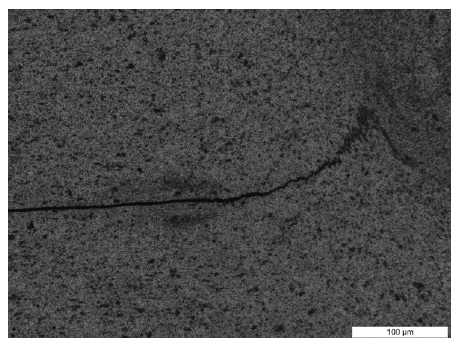
Figure 5. Edge the bonding